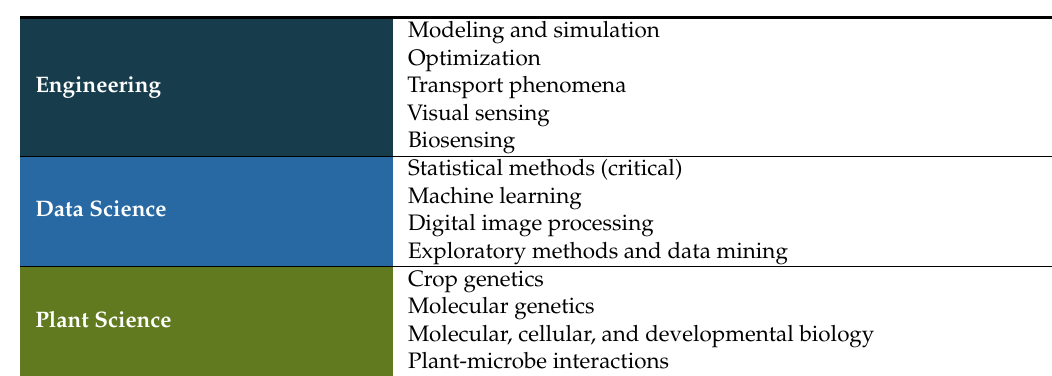
Table 2. Critical skills in each disciplinary